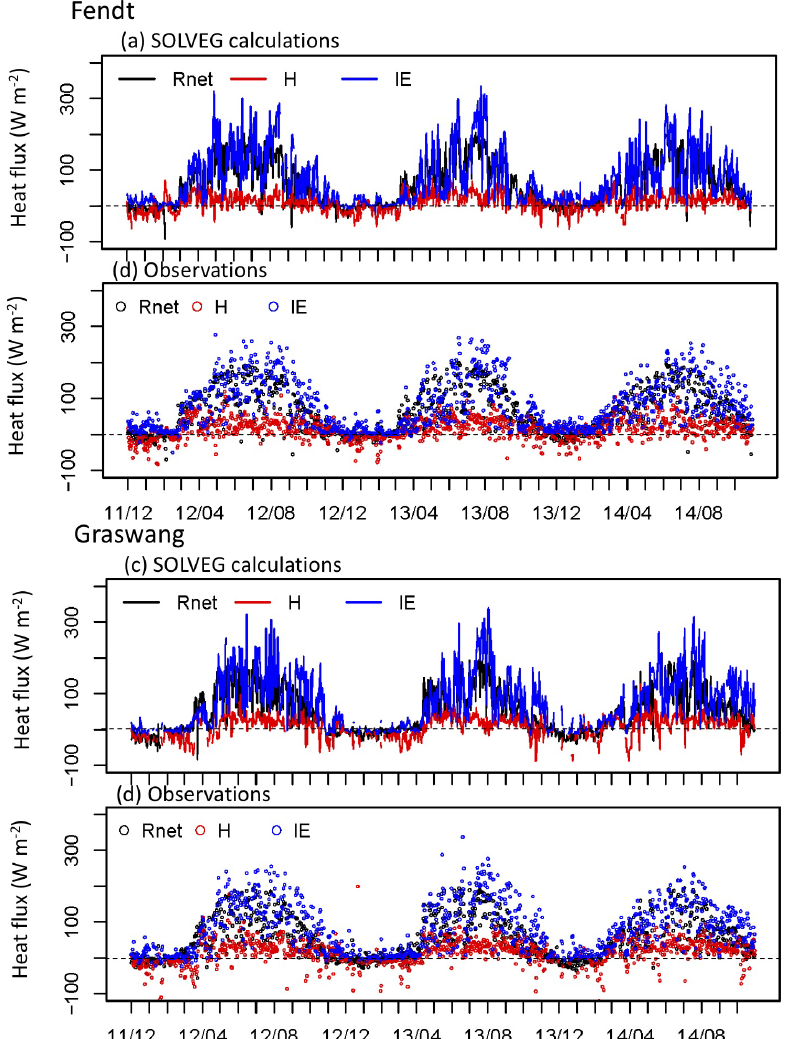
Figure 1. Time series for (a, c) calculated (lines) and (b, d) observed (open circles) daily mean net radiation ( R net ), sensible heat flux ( H ), and latent heat flux ( λE ) at (a–b) Fendt and (c–d) Graswang throughout the study